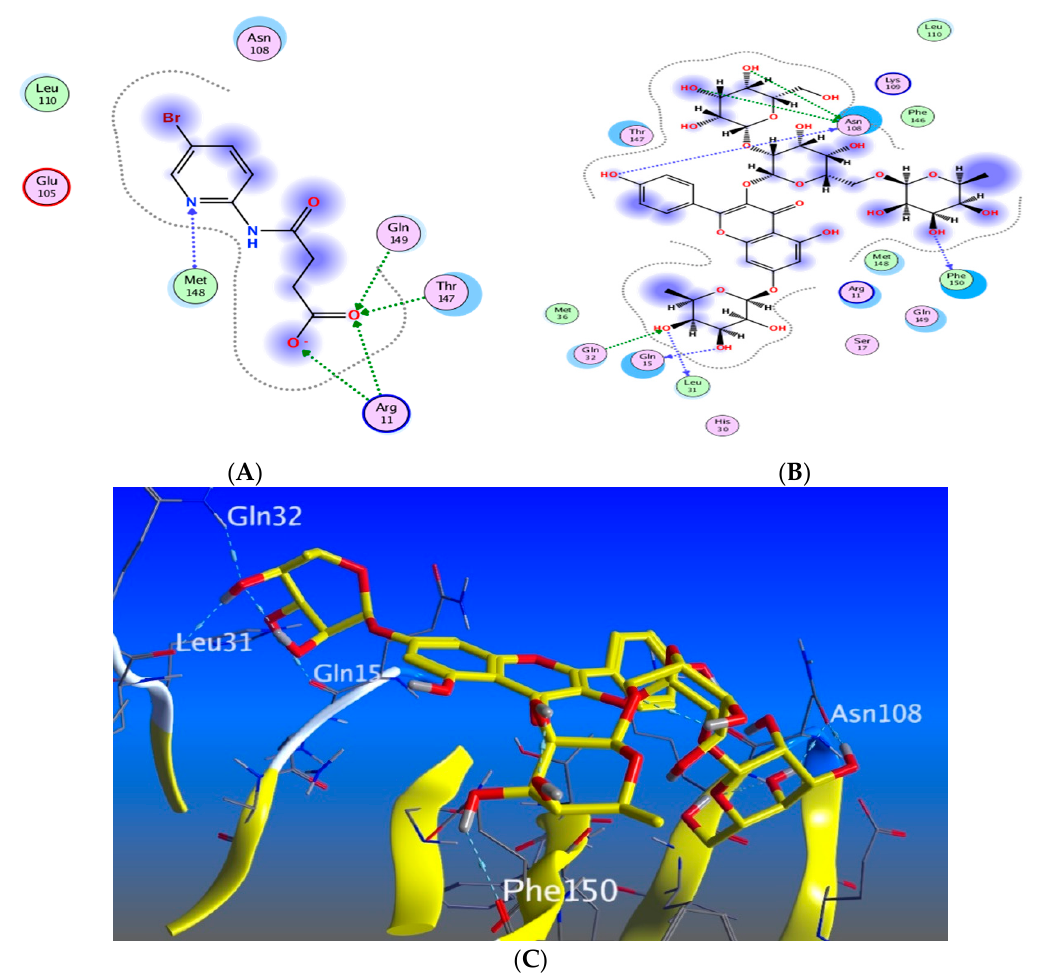
Figure 15. Docking results of compound 14 in the active pocket site of IL-1 β (PDB:6Y8M): ( A ) 2D interactions of ligand; ( B ) 2D interactions of compound 14 ; ( C ) 3D Docking pose of compound 14